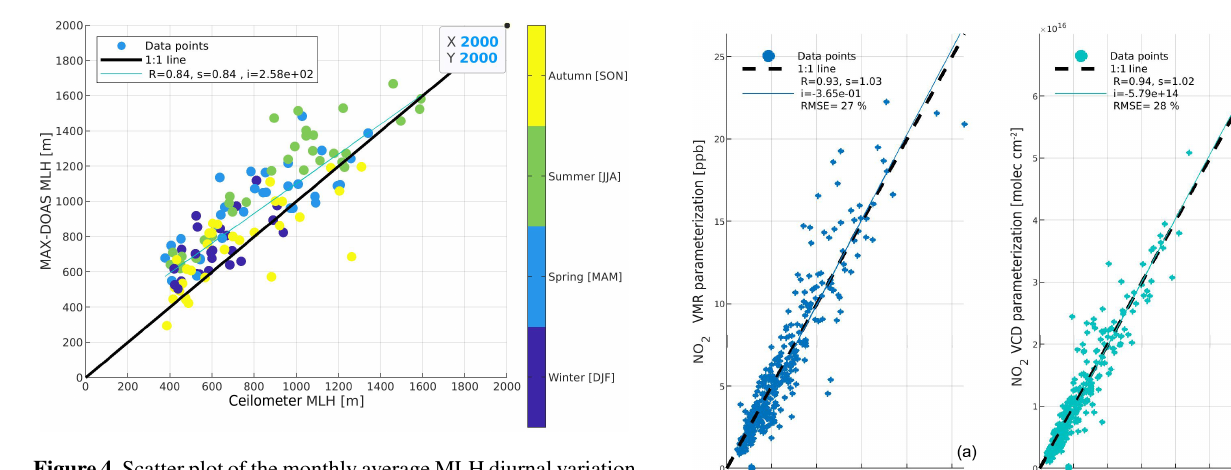
Figure 4. Scatter plot of the monthly average MLH diurnal variation values of the MAX-DOAS and the colocated ceilometer. The color bar separates the data by season.